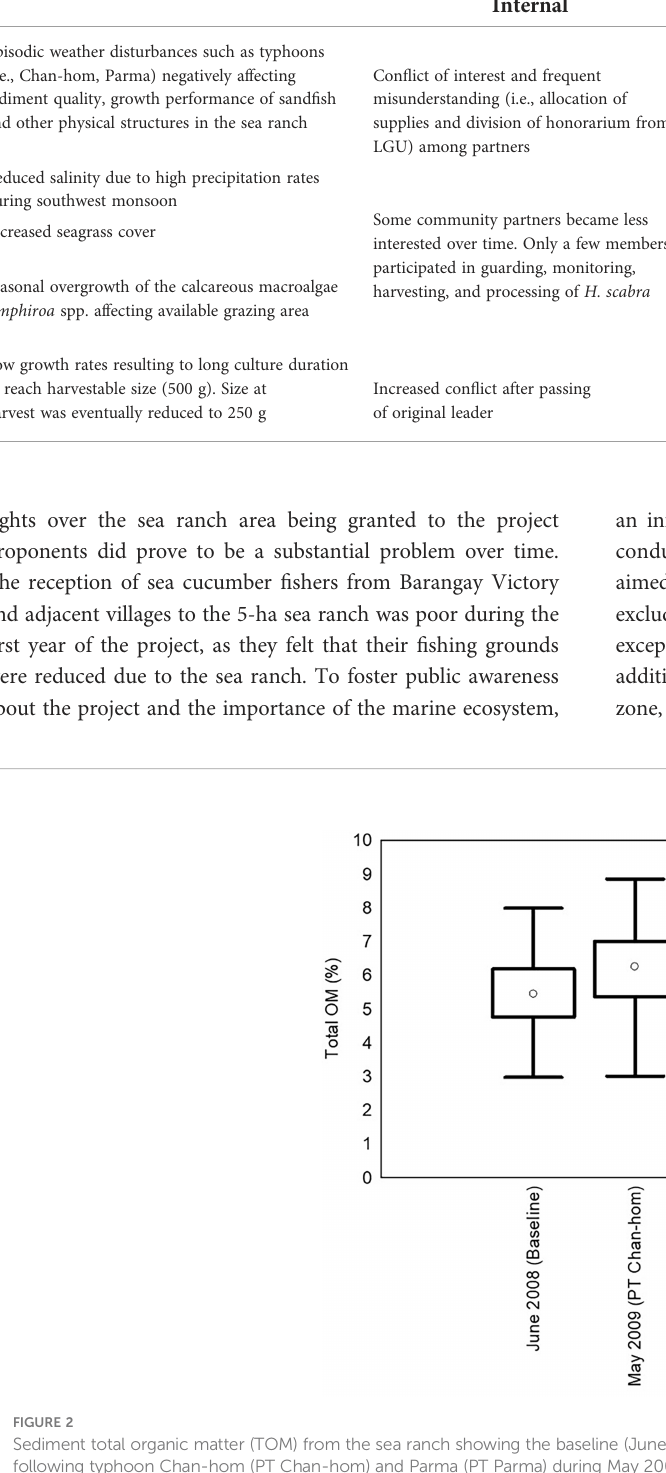
TABLE 2 List of challenges encountered by the community-based sea cucumber sea ranch at Barangay Victory, Bolinao, Northwestern Philippines. Natural Social